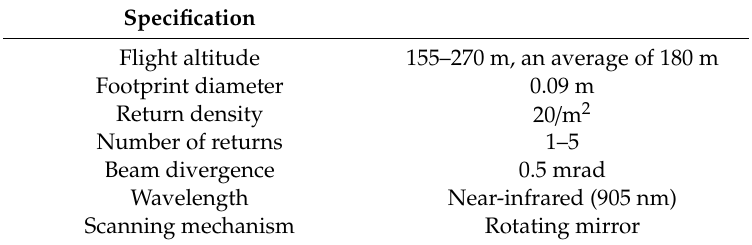
Table 1. Specification of LiDAR (Airborne Light Detection and Ranging) system and LiDAR data.